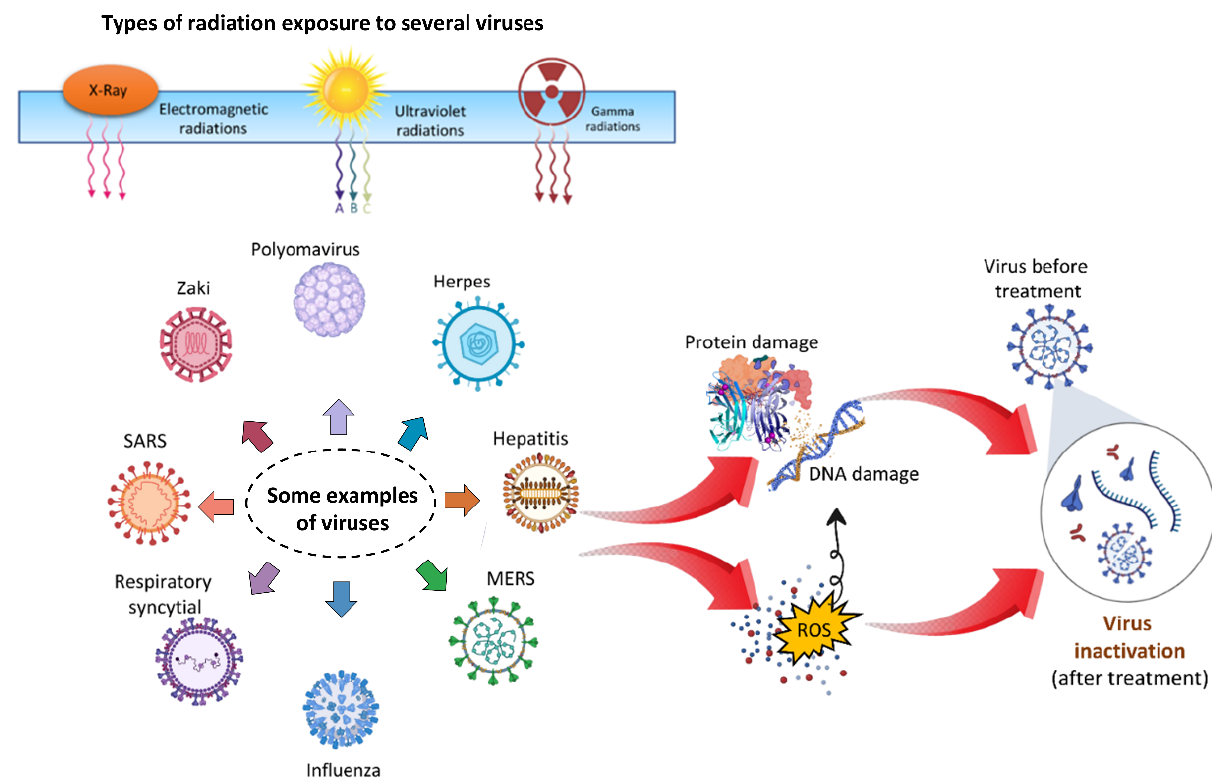
Figure 6. Illustration of the direct and indirect impacts of several types of radiation on microorganisms. Radiation can cause direct DNA and protein damage which leads to virus inactivation. On the other hand, radiation can also cause the generation of ROS in response to oxidative stress, which also causes to damage the DNA and proteins of microorganisms and lead to inactivation.